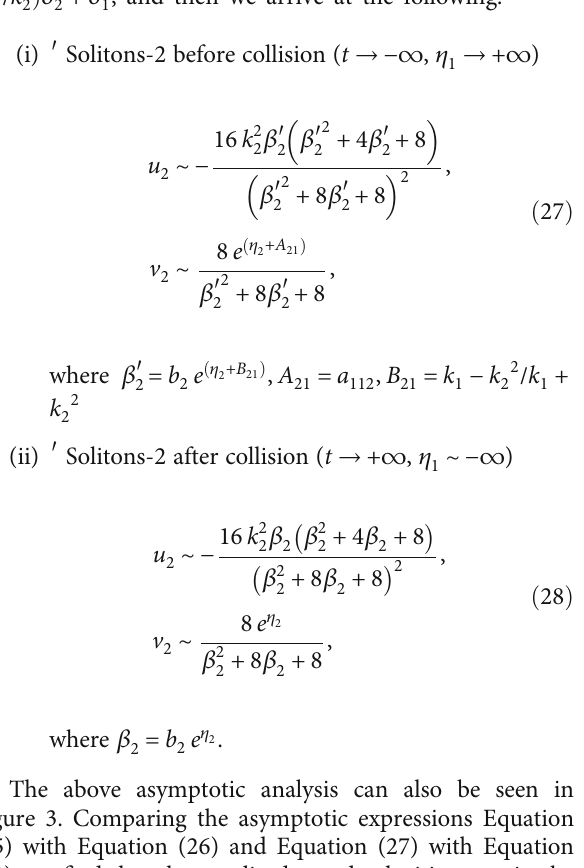
Figure 3. Comparing the asymptotic expressions Equation (25) with Equation (26) and Equation (27) with Equation (28), we fi nd that the amplitudes and velocities remain the same, but the phases are changed. To illustrate the collision process exactly, the graphs are presented in Figure 2, which shows that the collisions of the two-soliton waves are exactly elastic.